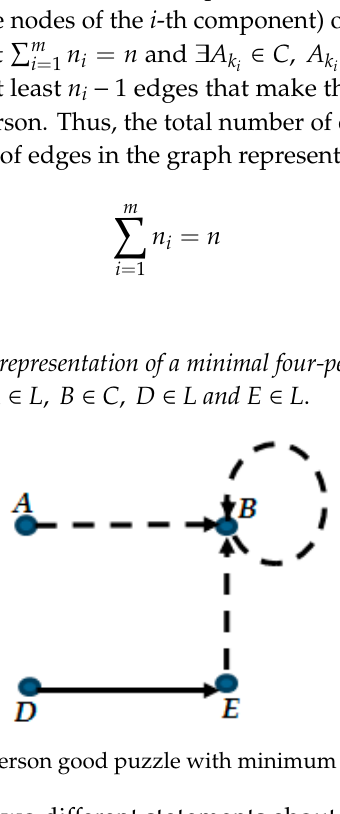
Table 3. The number of good, solvable (including good ones), and unsolvable Strong Truth-Teller– Strong Liar (SS)- and Strong Truth-Teller–Strong Liar–Strong Crazy (SSS)-puzzles with two, three